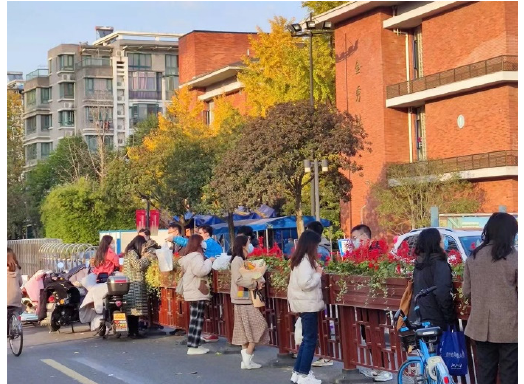
Figure A2. Gated entrance with intelligent access control facilities and 24 h campus guards (photo taken on 9 September 2022).